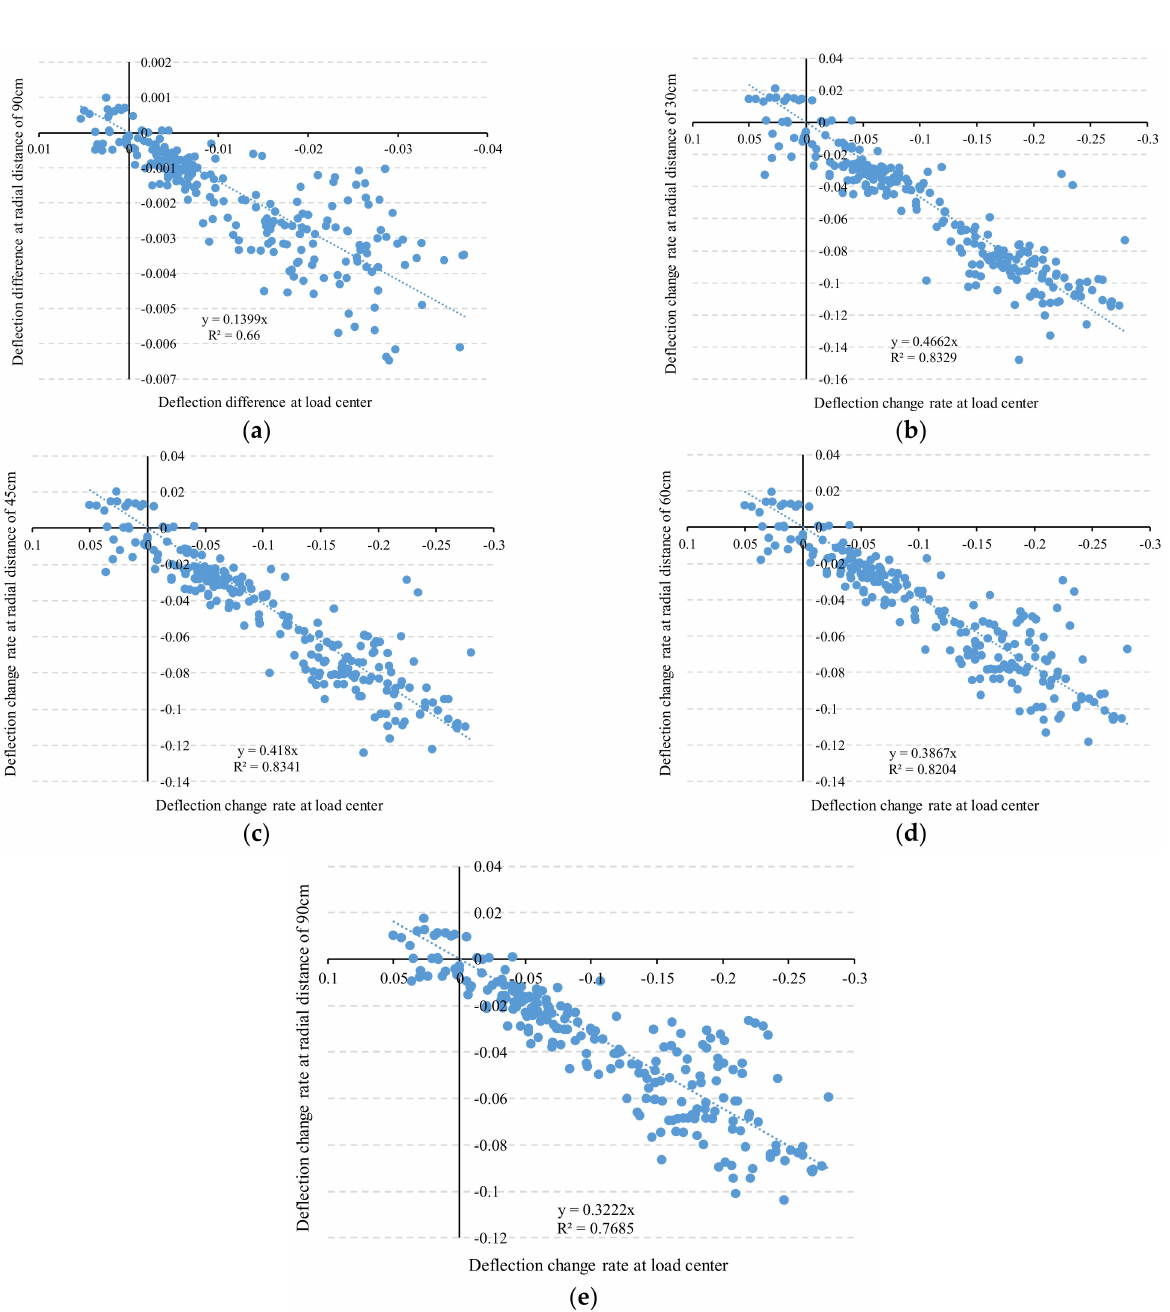
Figure 9. Fitting results between deflection rate at different radial distances and load center deflection